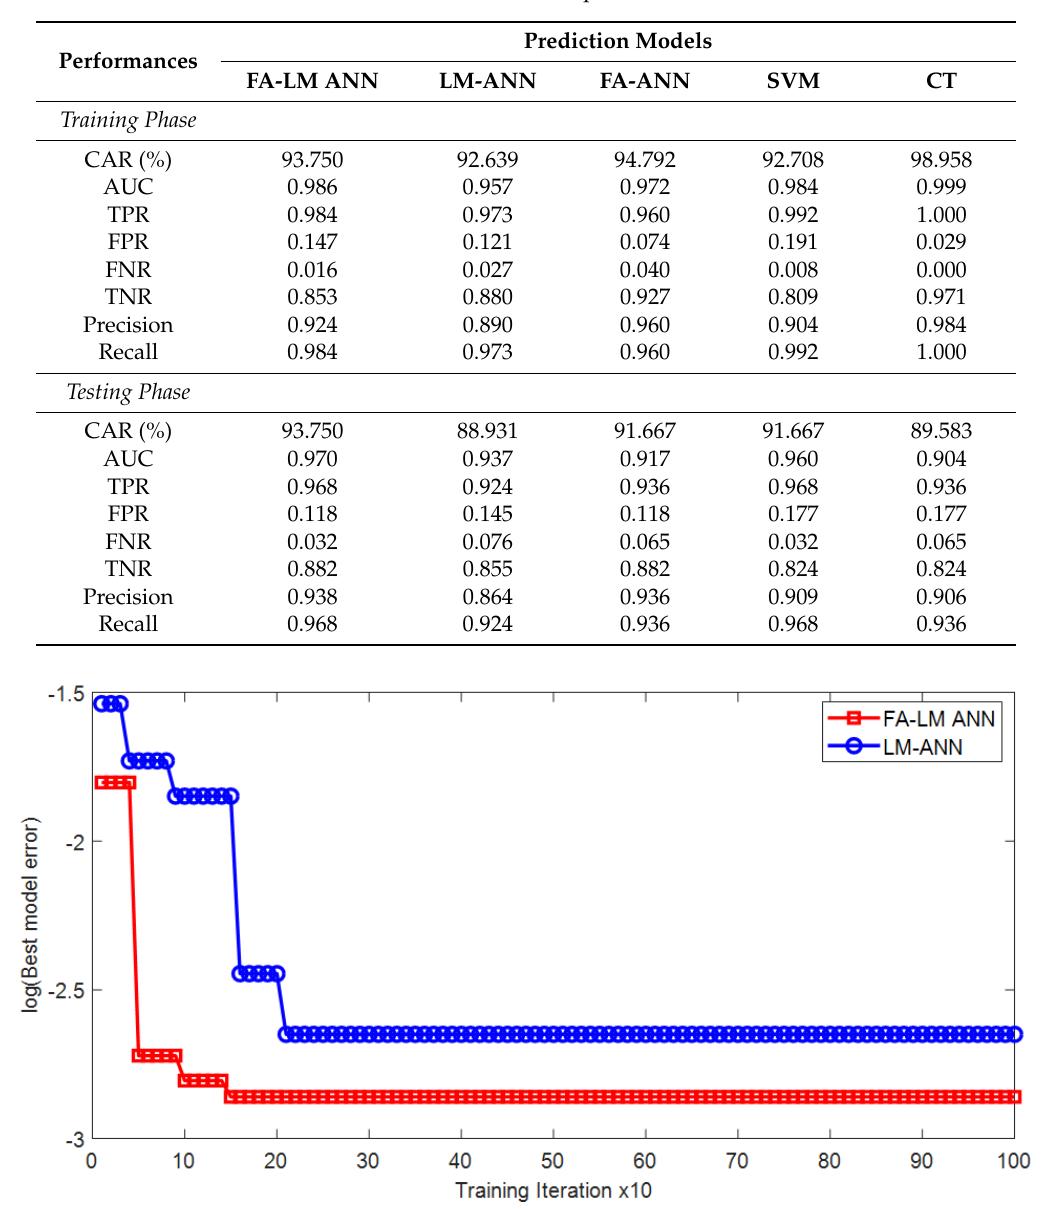
Figure 14. Comparison of convergence rates between FA-LM ANN and LM-ANN.